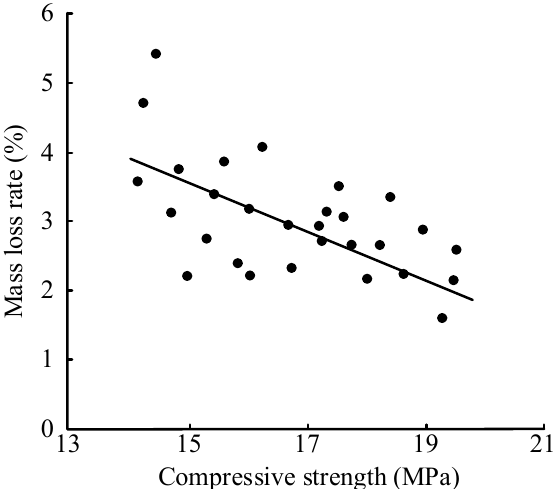
Figure 8. Correlation between compressive strength and mass loss rate.